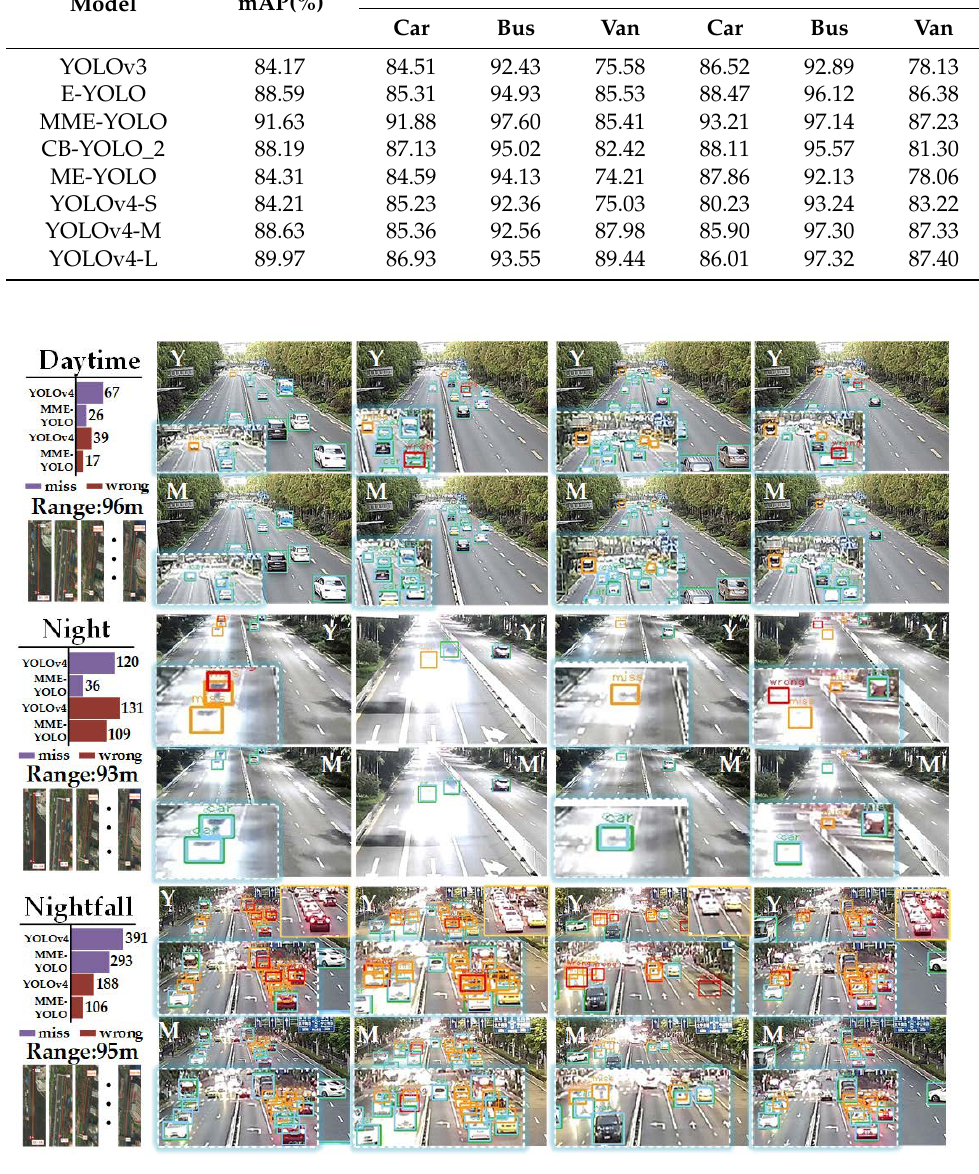
Figure 10. Comparison between YOLOv4-L and MME-YOLO on the Road-side Dataset. Error histograms showed in the top-left corner. Minimum–maximum distances are listed in the bottom-left corner. Qualitative images are shown on the right. Light blue bounding boxes refer to the ground truth; red ones mean that wrong positions were predicted; orange ones mean that missed targets; green ones mean matched detections. We manually enlarged the areas for better visualization.